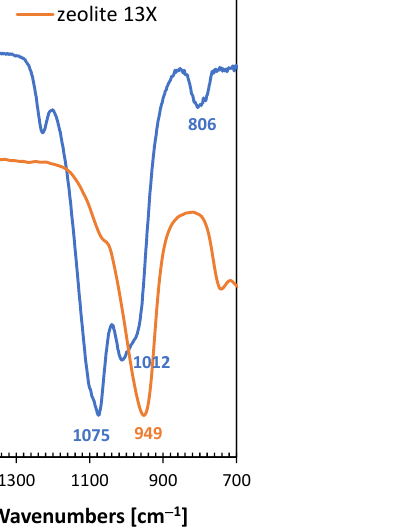
Figure 4. Comparison of FTIR/ATR spectra of the regenerated zeolites 13X and Z310.